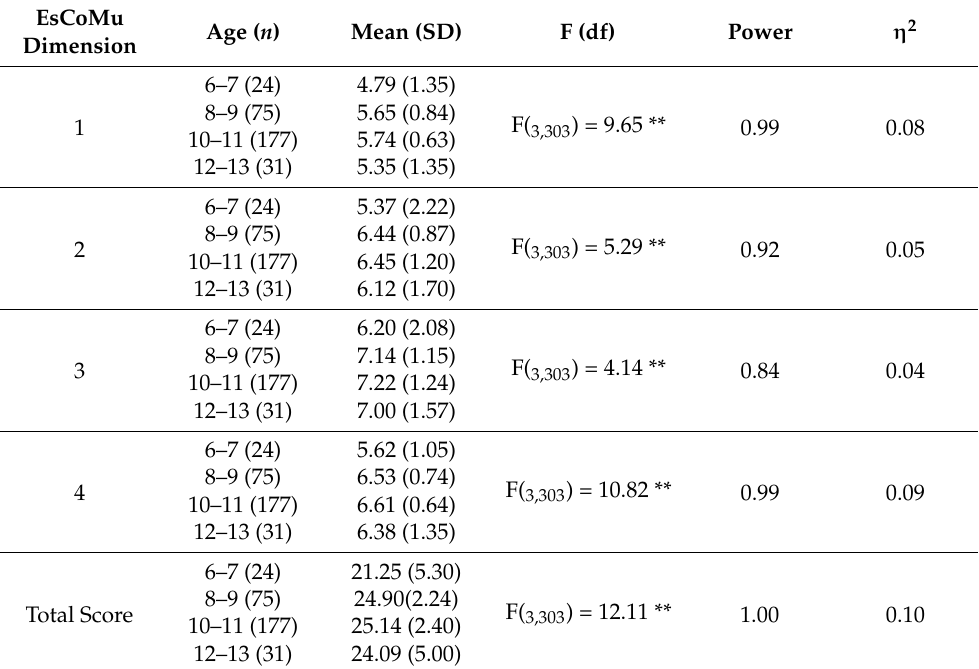
Table 6. MANOVA results for school setting with EsCoMu dimensions and total scores.